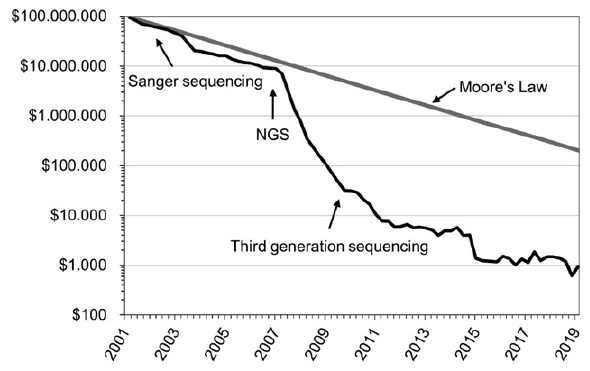
Figure 1: Sequencing cost for the human genome. The departure of sequencing cost curve from Moore’s law coincides with the emer- gence of next generation sequencing (NGS). Moore’s law originates in the computer hardware industry that involves doubling of ‘com- puting power’ every two years. It is considered that technologies that follow the law are regarded as successful. 6 It thus represents a useful relationship to compare technology advances. Data shown in the figure was obtained from the National Human Genome Re- search Institute.